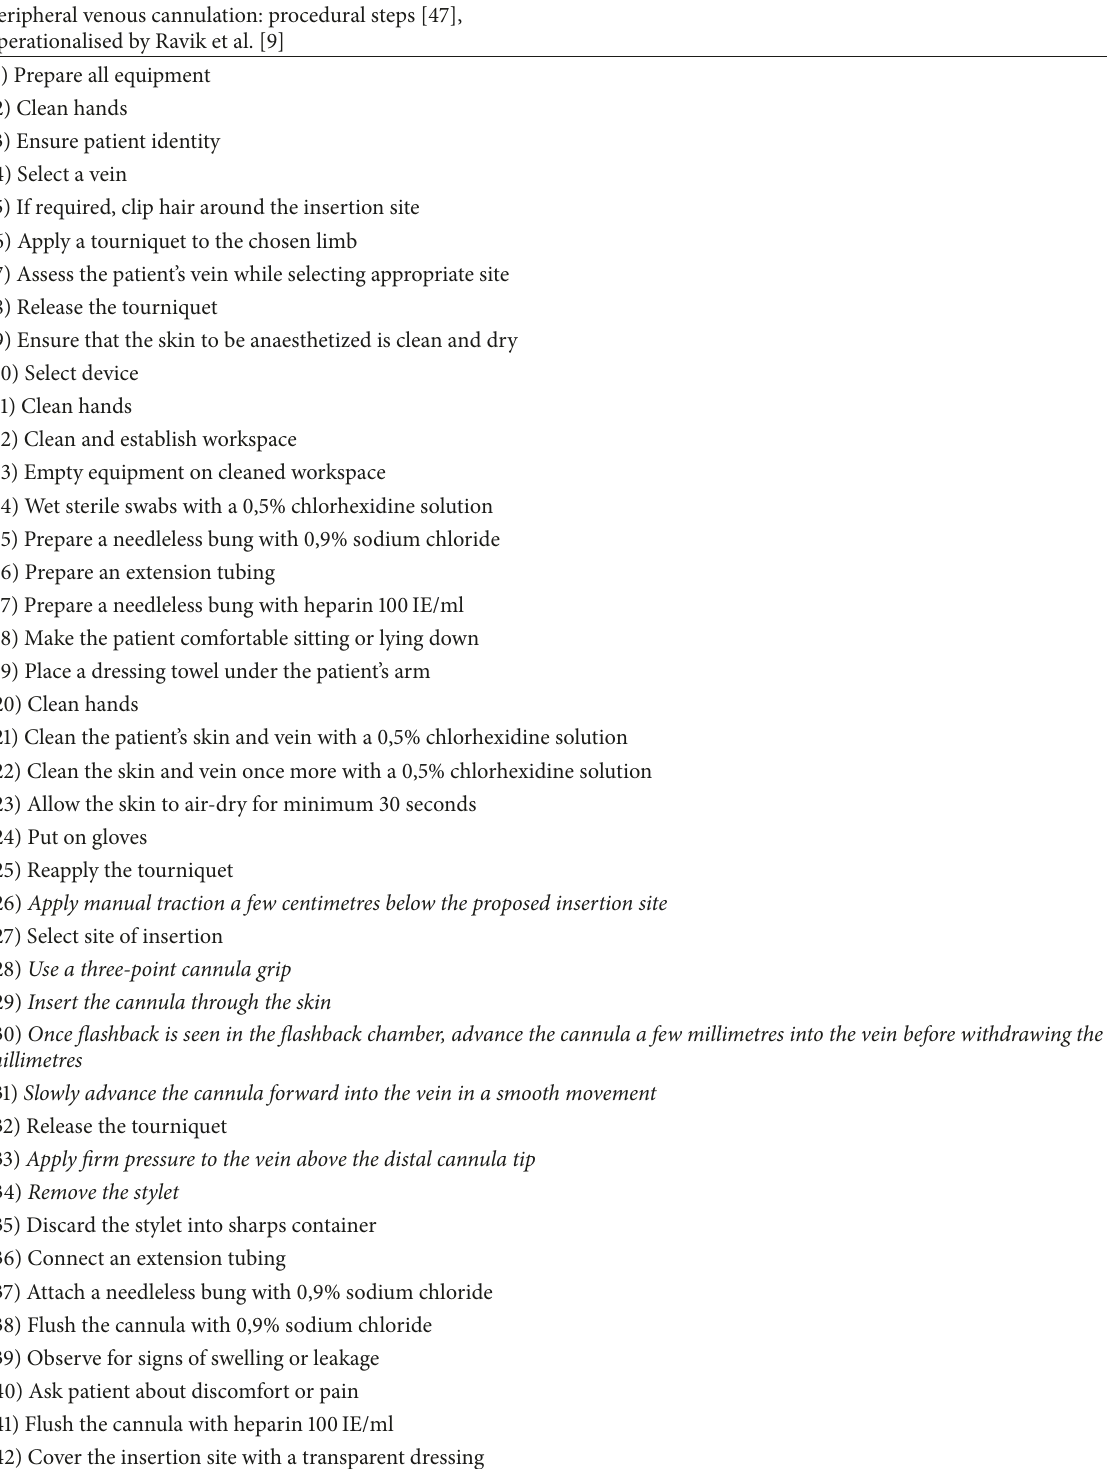
Table 1: Illustration of the procedural steps of PVC. The seven steps concerning the technical implementation of vein cannulation are